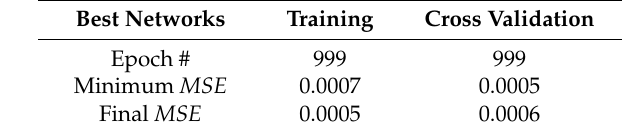
Table 1. Results of minimum and final mean square error ( MSE ) for the self-organizing feature map (SOFM-1000) network.